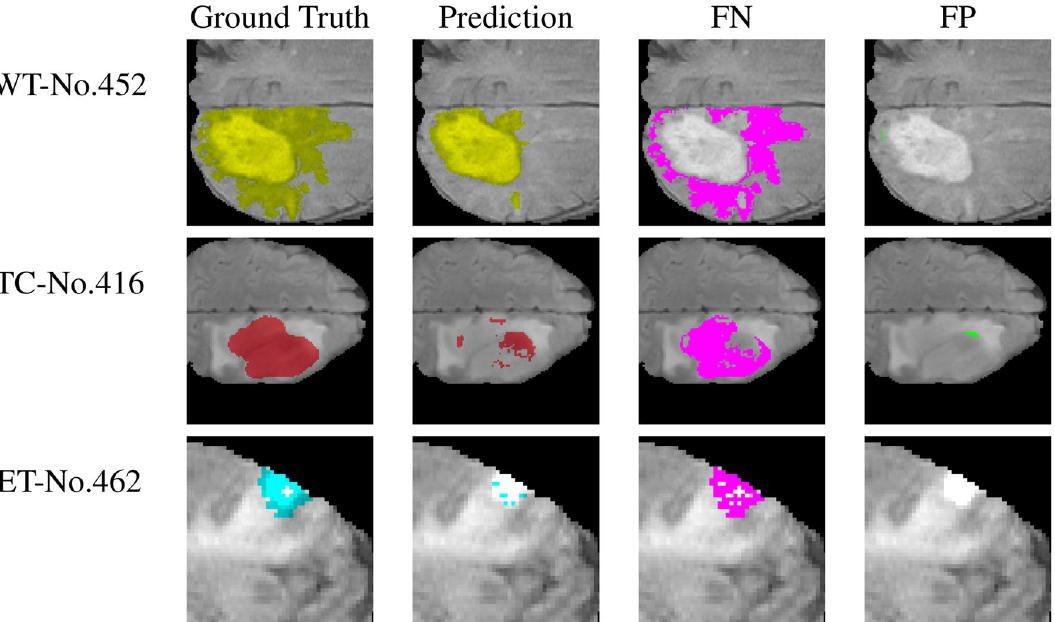
Figure 9. The worst WT (yellow) and TC (red) and ET (blue) testing cases: Cross-sections of no. 452 at 95 along the z-axis, no. 416 at 123 along the z-axis, and no. 462 at 56 along the z-axis for the ground truths, prediction, false negative (purple) and false positive